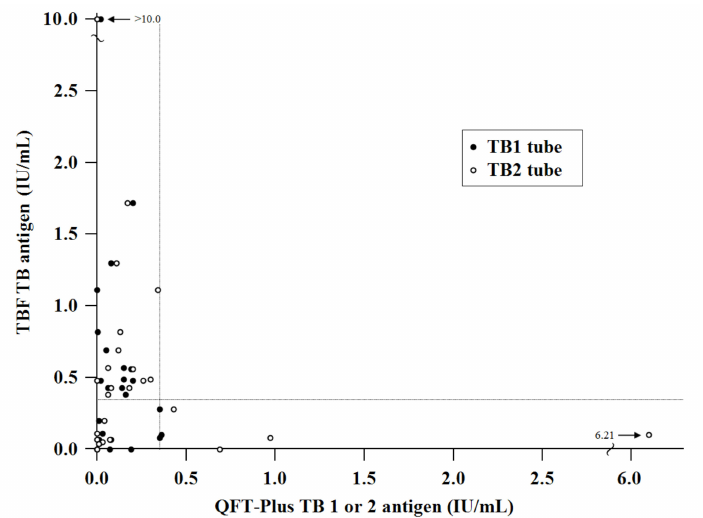
Figure 2. Scatter plot of IFN- γ concentrations in 25 cases with discrepant results between the TBF and QFT-Plus tests. Cut-off of both tests: IFN- γ 0.35 IU/mL (dotted line). Abbreviation: IFN- γ , interferon-gamma; TBF, Standard E TB-Feron ELISA; QFT-Plus, QuantiFERON-TB Gold Plus; TB,